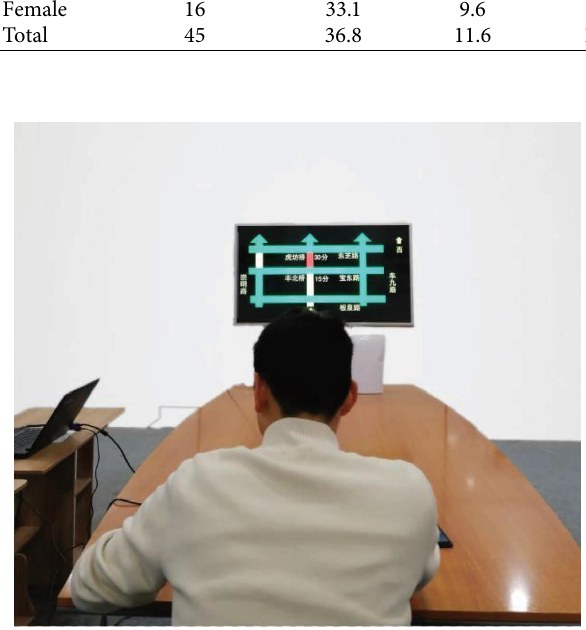
Figure 2: Environment of the static cognitive